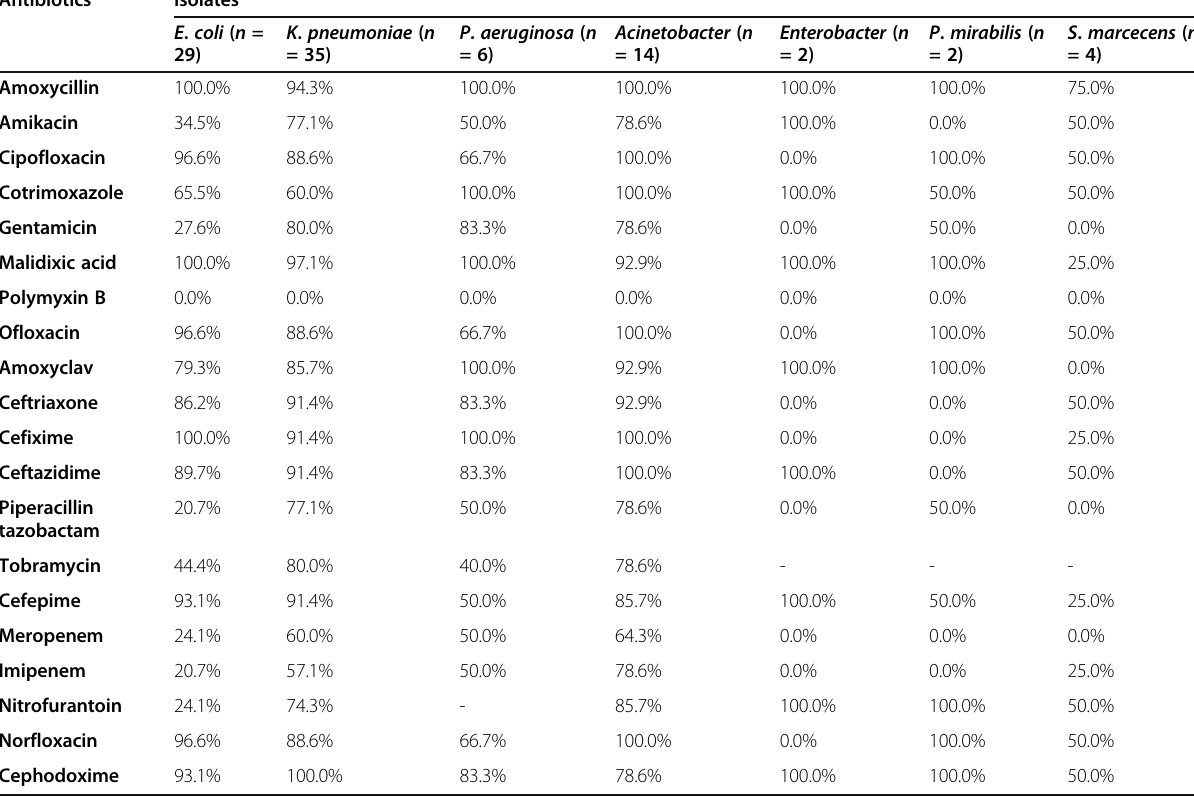
Table 2 Organism-wise antibiotic resistance pattern